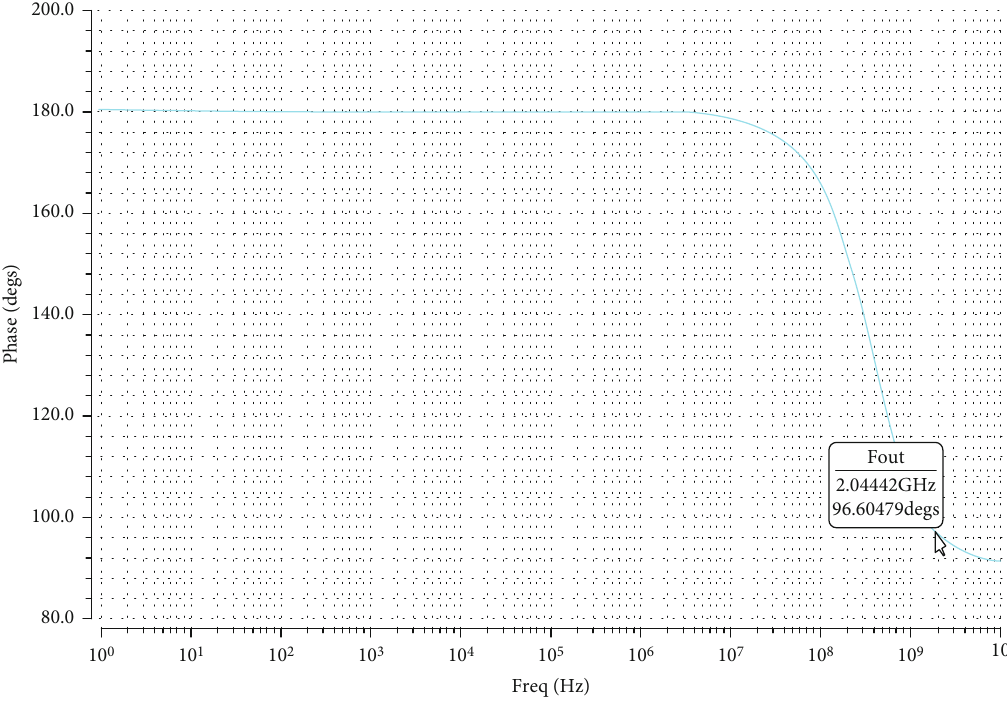
Figure 9: Phase plot of FinFET two-stage Table 3: Comparison table of polymer-based two-stage di ff erential OP-Amp with CMOS and FinFET technology. Parameter